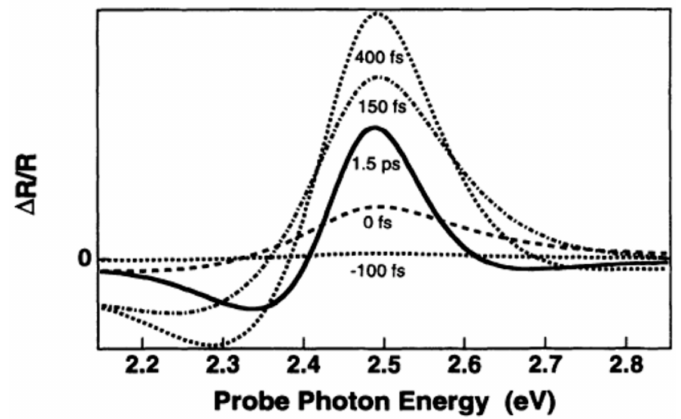
Figure 11. Calculated ∆ R/R spectra after excitation of respective particles. (Reproduced with permission from Figure 12b in